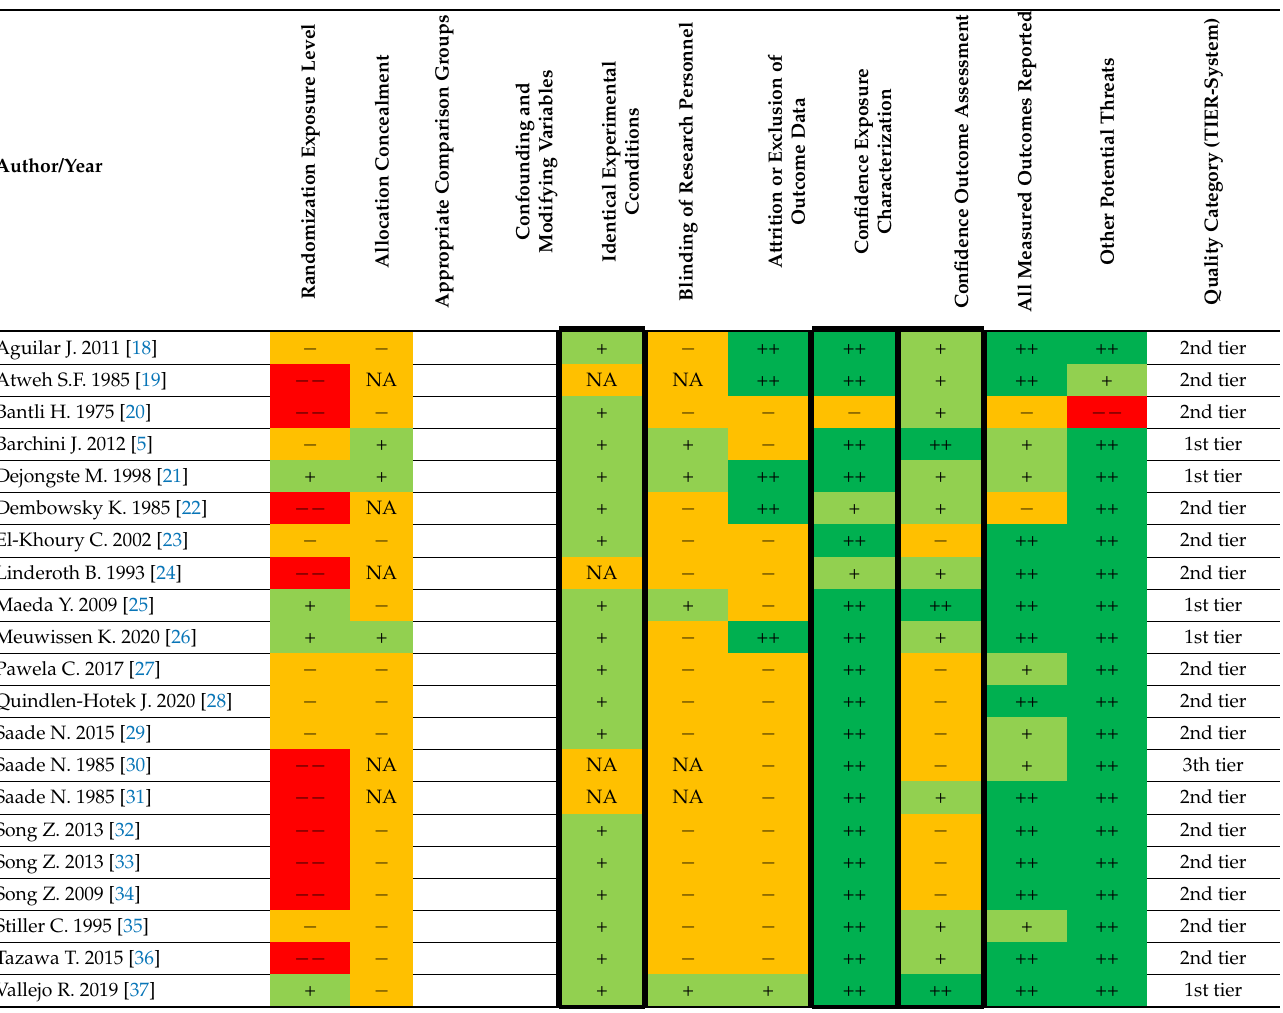
Table 2. Risk of bias in individual animal